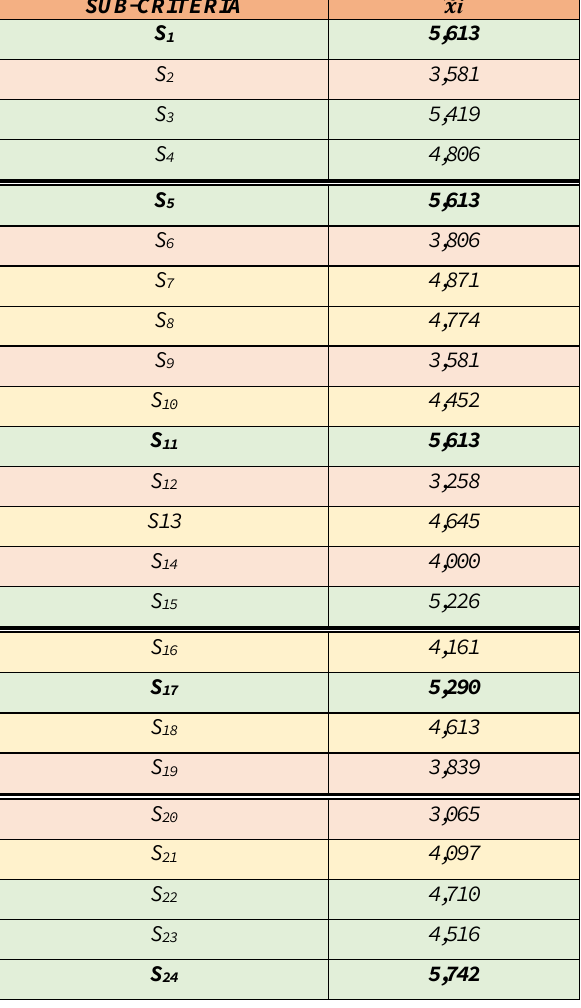
Table 3. Average values of sub-criteria